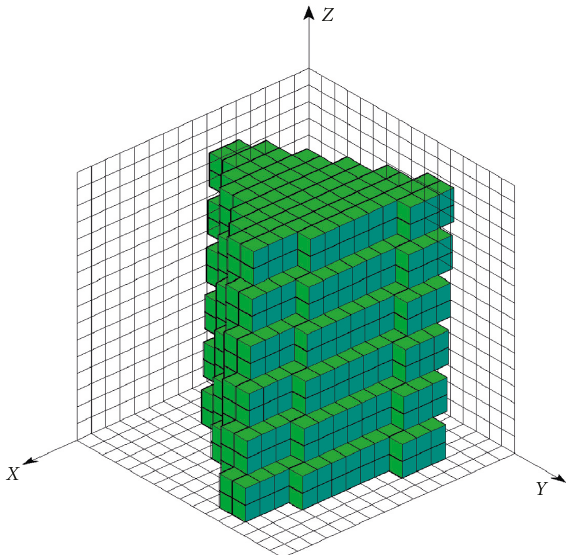
Figure 8: OBST representation for SweptArea.